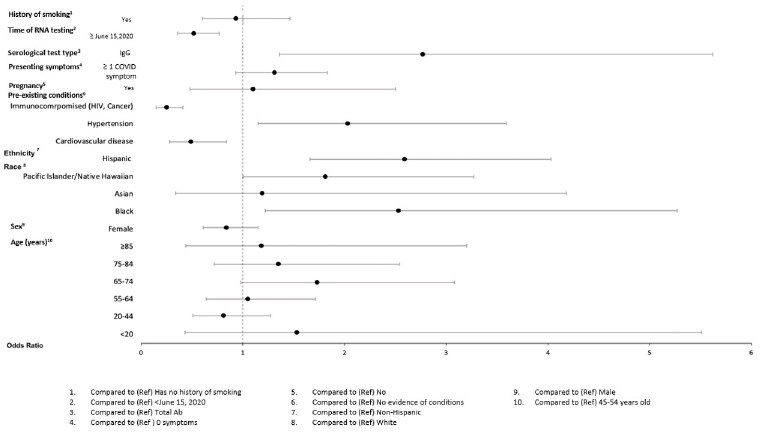
Fig 7. Odds of seropositivity dataset